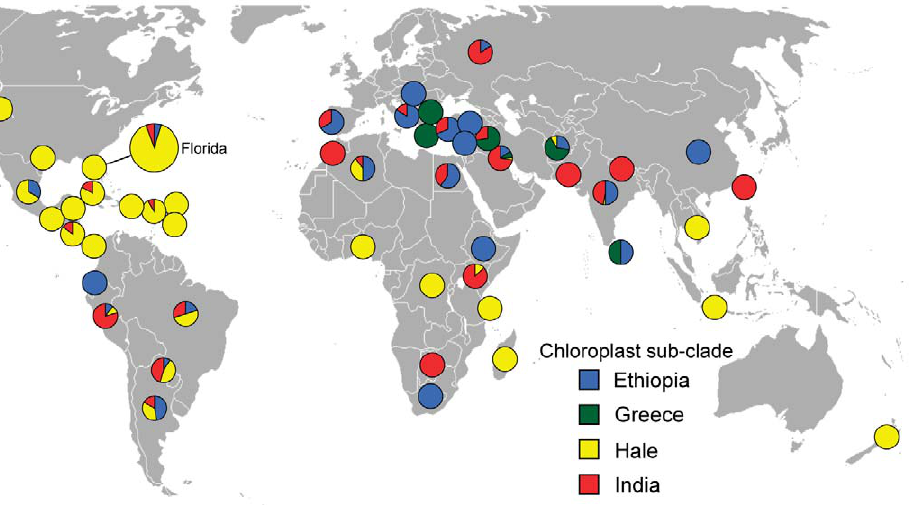
Figure 5. Worldwide distribution of chloroplast genotypes of castor bean from a collection of 894 accessions. Distribution of chloroplast genotypes corresponding to the sub-clades shown in Figure 4, based on the origin of each accession. The pie chart corresponding to Florida is expanded to reflect the larger number of samples ( n =272) that came from that state, relative to other parts of the world.